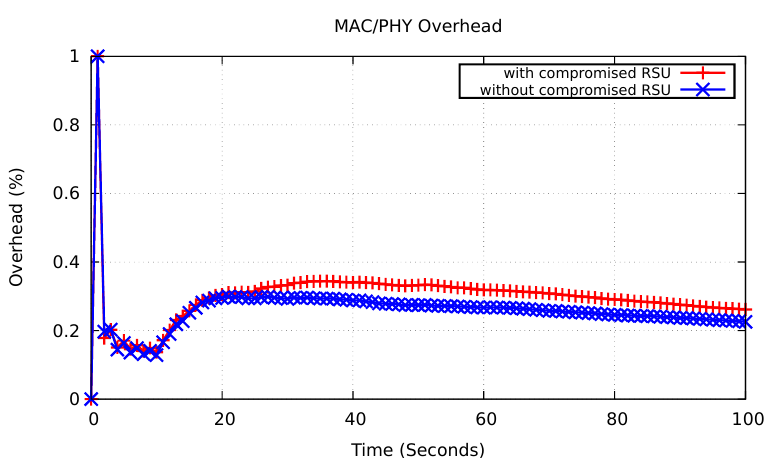
Figure 12. MAC/PHY overhead with compromised RSUs.